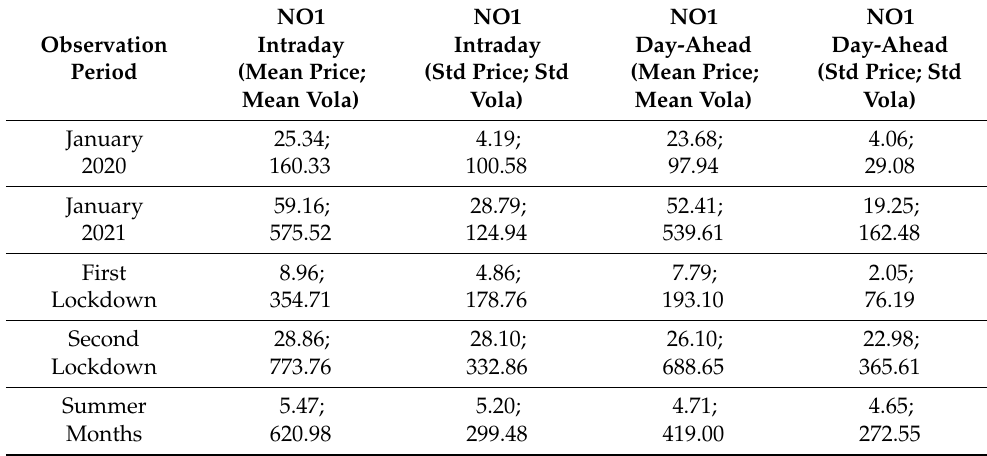
Figure 14. This figure represents the day-ahead price levels for NO1 power including its confidence levels on the left side and the 30-day volatility including its confidence levels on the right side. Figures 7, 8 and 11–14, got generated using the same code in Python. Table 7. General Statistics about NO1 Prices and Volatilities in